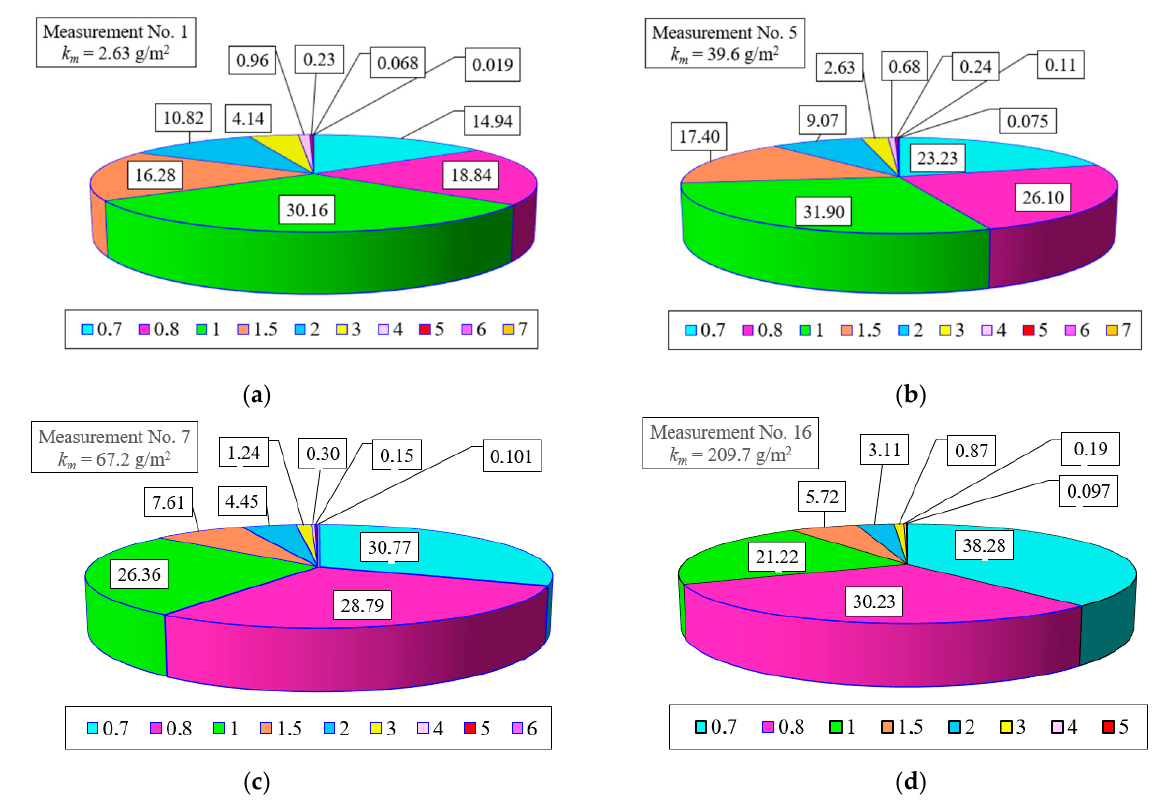
Figure 26. Granulometric composition of grains in the air behind the PC-2 filter after reaching suc- cessive values of dust absorption coefficients: ( a ) k mPC = 2.63 g/m 2 (measurement No. 1), ( b ) k mPC = 39.6 g/m 2 (measurement No. 5), ( c ) k mPC = 67.2 g/m 2 (measurement No. 7), ( d ) k mPC = 67.2 g/m 2 (meas- urement No. 16).